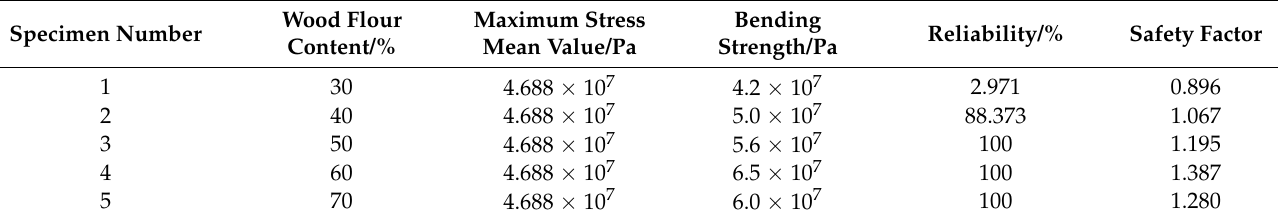
Table 3. Results of the wood flour content on